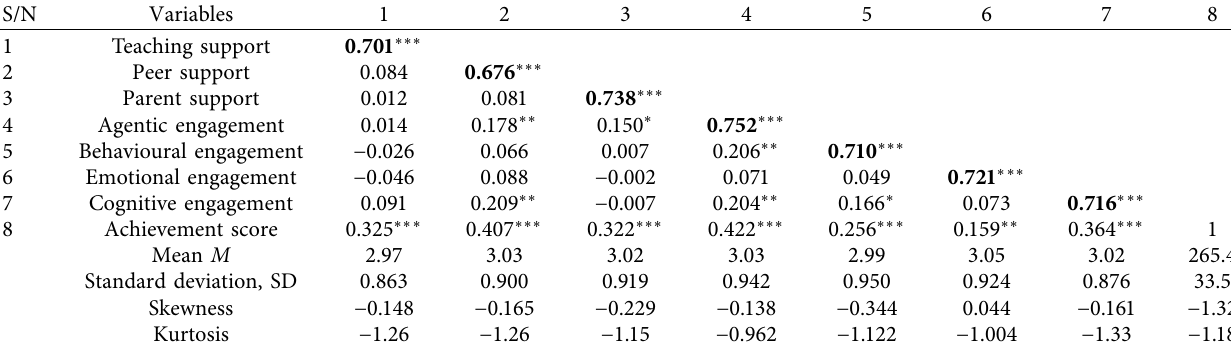
Table 3: Means, standard deviation, skewness, kurtosis, and bivariate correlation among the variables.